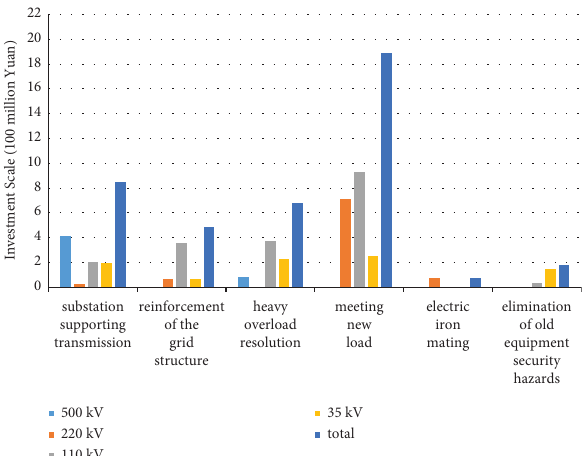
Figure 5: Optimal solution with an economic beneft objective at 500kV/220kV/110kV/35kV voltage levels.